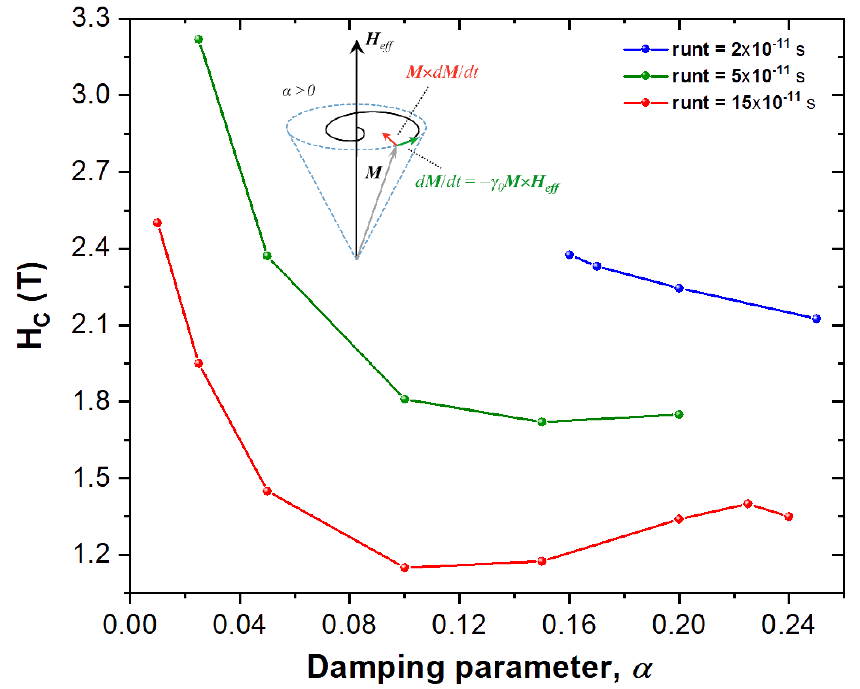
Figure 4. Relation between coercivity ( H c ), damping parameter α , and run time (runt). The inset shows how the dissipative term M × dM / dt , driven by the phenomenological constant α , forces the magnetization to precess until the magnetization aligns itself with the effective field ( H eff ) direction. In general, as α is increased the coercivity is lowered until a minimum is reached. Also the longer the runt, the longer the magnetization dynamics has to relax to equilibrium at each effective field value, reducing the coercivity as well. These simulations were performed at 0